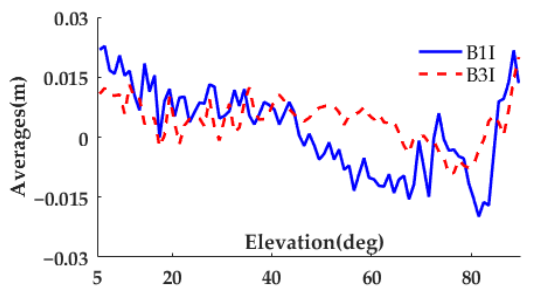
Figure 3. Averages of multipath error at B1I and B3I in each elevation bin.